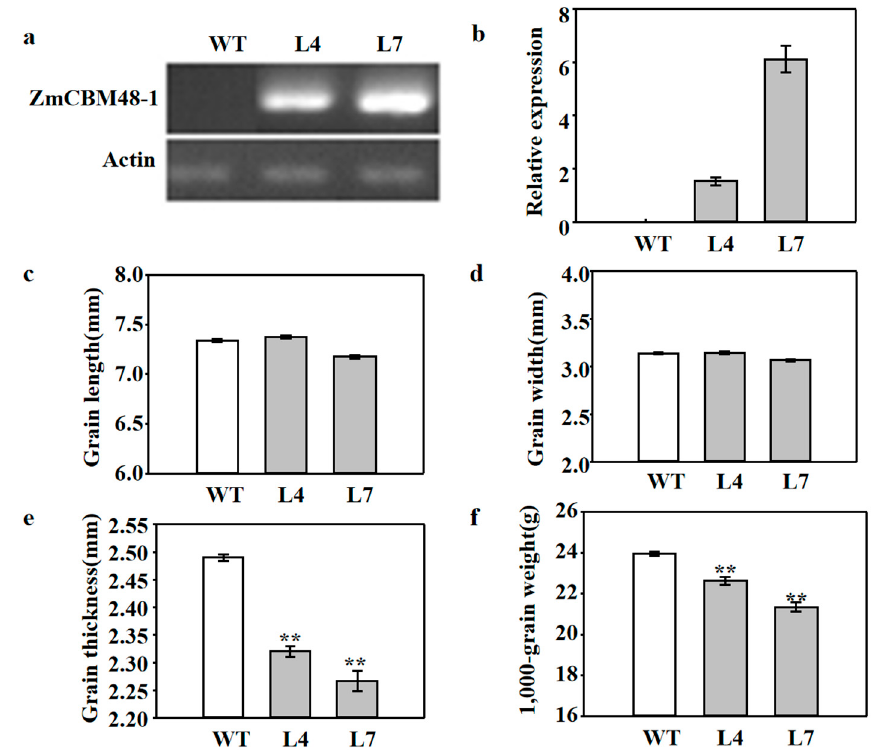
Figure 4. Agronomic character analysis of the ZmCBM48-1 transgenic rice lines. ( a , b ) Molecular identification of ZmCBM48-1 transgenic rice plants. WT: wide type, L4 and L7 represent the different transgenic lines, OsActin1 was used as an internal control. ( c ) Length of seeds. ( d ) Width of seeds. ( e ) Thickness of seeds. ( f ) The 1000-grain weight of the seeds. Data are presented as means ± SD from three replicates. ** represents significant differences between WT and transgenic plants at p < 0.01.